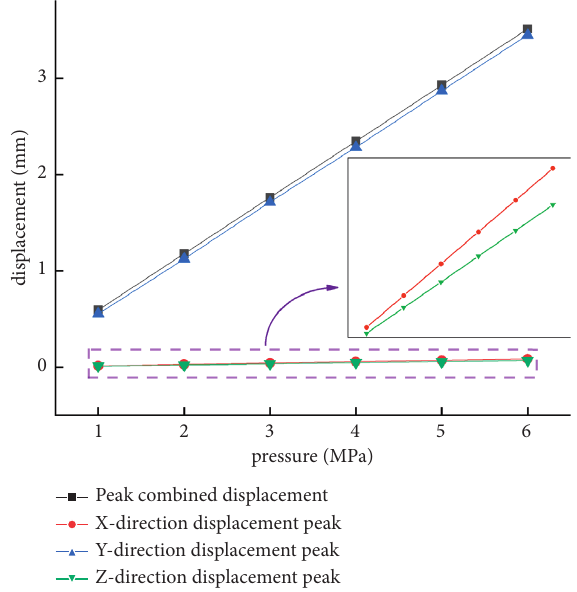
Figure 7: Variation curve of displacement peak in different di- rections with drilling fluid pressure.